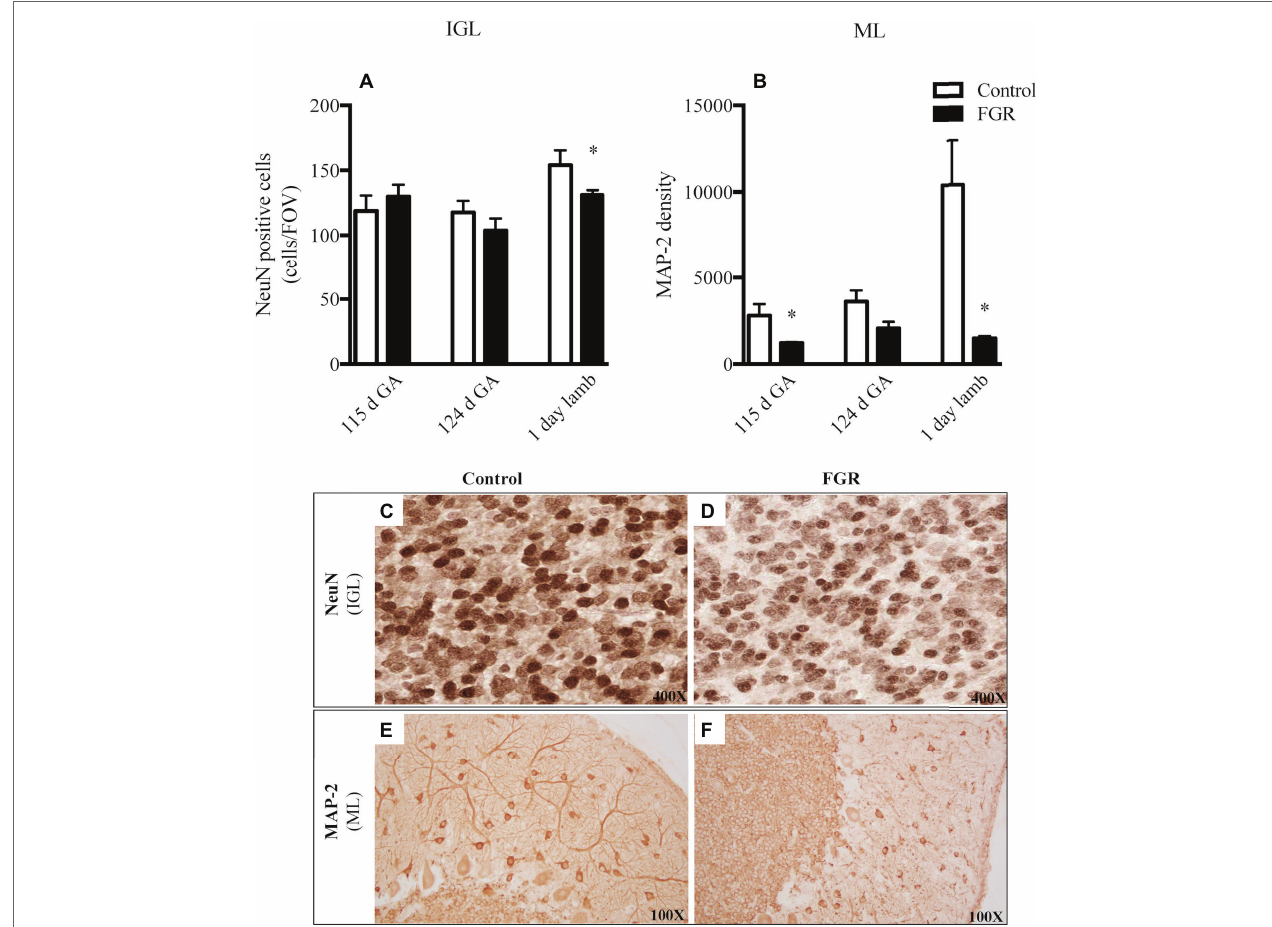
FIGURE 5 | The number of NeuN-positive cells per field of view (A) and MAP-2 density (B) in the internal granular layer (IGL) and molecular layer (ML) in the fetal brain at 115 d GA, 124 d GA, and 1-day-old lamb of control and FGR animals. Each bar represents the mean ± SEM; * p ≤ 0.05 versus control. Representative micrographs showing NeuN-positive immunoreactivity in the IGL (C,D) and MAP-2 in the ML (E,F) in 1-day-old lambs. Images from control (C,E) and FGR (D,F) animals are shown. FGR, fetal growth